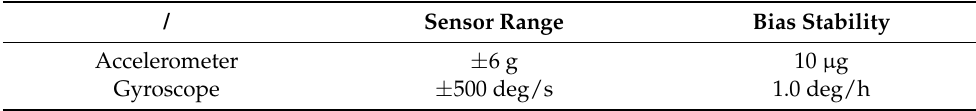
Table 4. Performance parameters of FSS-IMU6132.